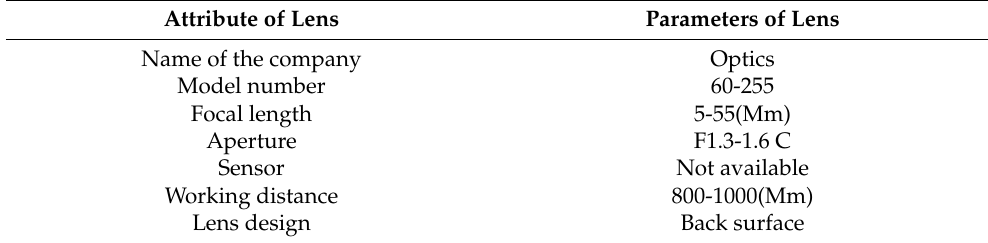
Table 2. Parameters of the lens used in the camera.